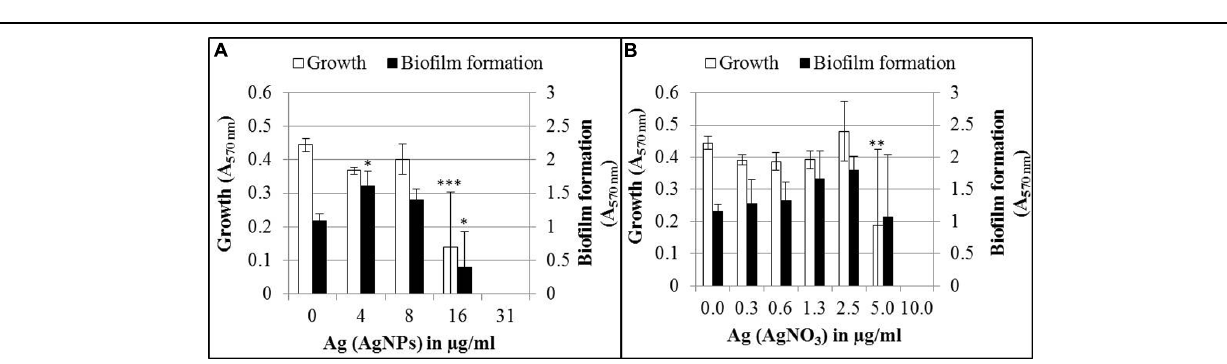
FIGURE 2 | Growth and biofilm formation of P. aeruginosa AdS in LB broth in the presence of different concentrations of AgNPs (A) and AgNO 3 (B). Statistical analysis: ANOVA followed by Dunett’s test. Statistically significant ( ∗ p < 0.05), very statistically significant ( ∗∗ p < 0.01), highly statistically significant ( ∗∗∗ p < 0.001), n = 3.